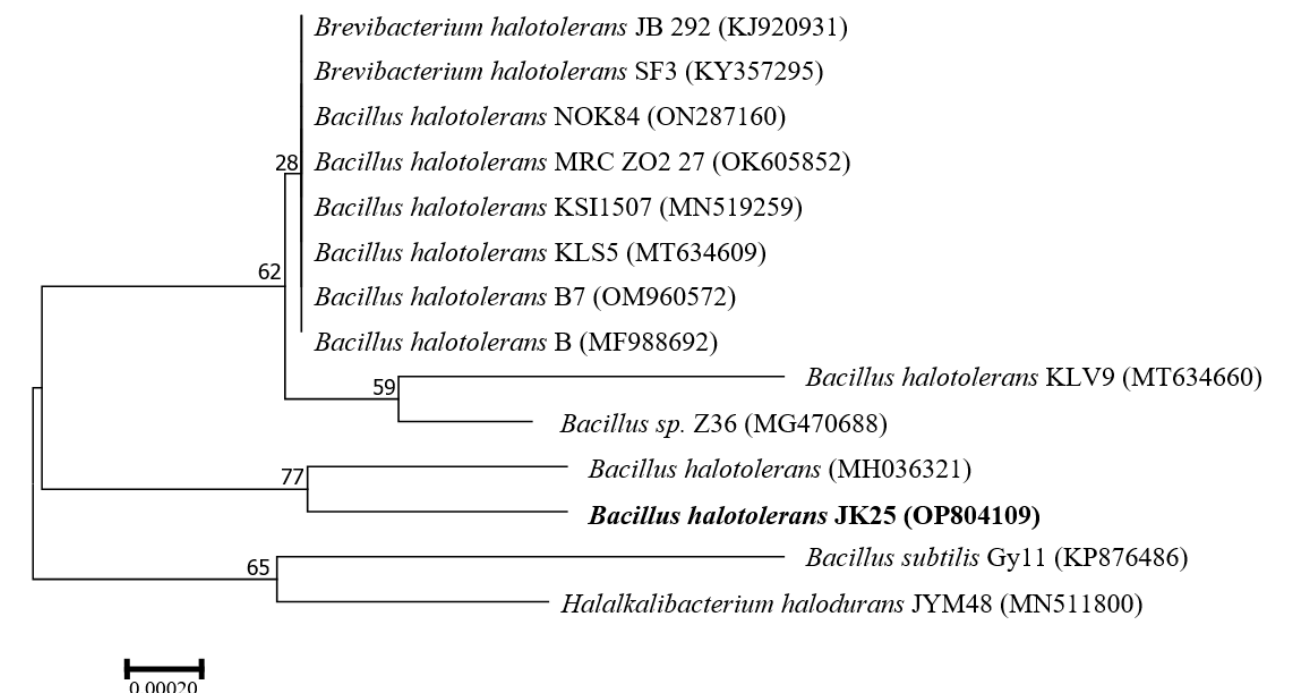
Figure 1. Phylogenetic tree constructed based on 16S rRNA sequences of JK-25. The comparison results were analyzed with MEGA 7.0 software and a tree was built using the neighbor joining method (1000 bootstrap values). Bold is the branch of strain JK-25, whose NCBI registration number is OP804109.